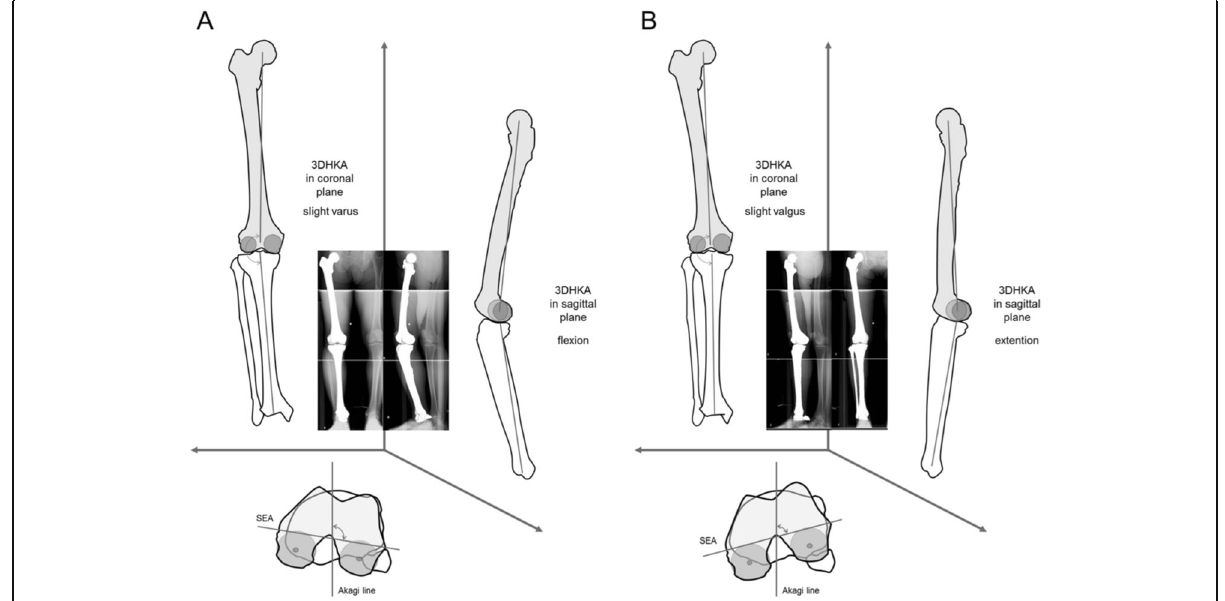
Fig. 5 Representative images showing the difference between men ( a ) and women ( b